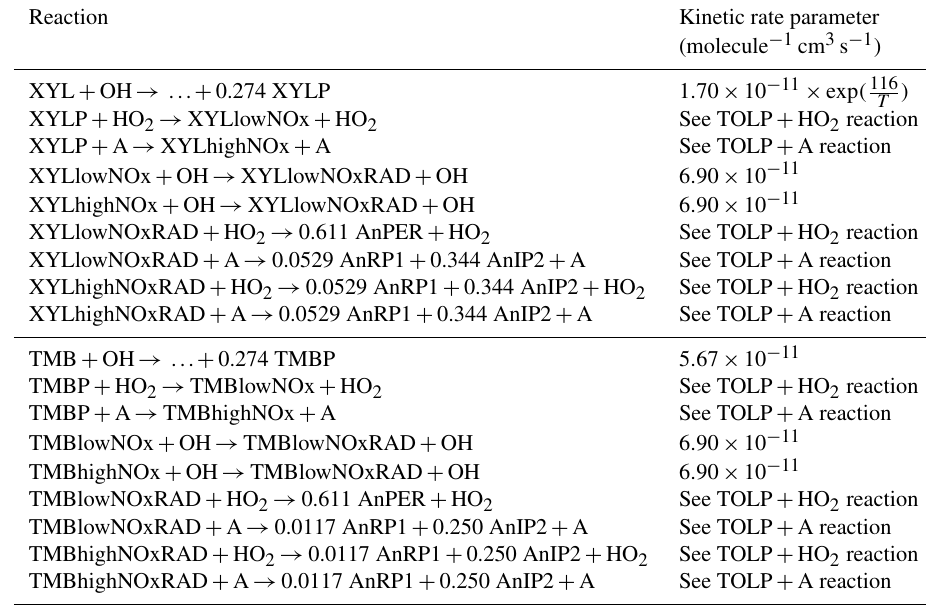
Table 5. Reactions leading to SOA formation ∗ from o-xylene (referred to as XYL) and 1,3,5-trimethylbenzene (referred to as